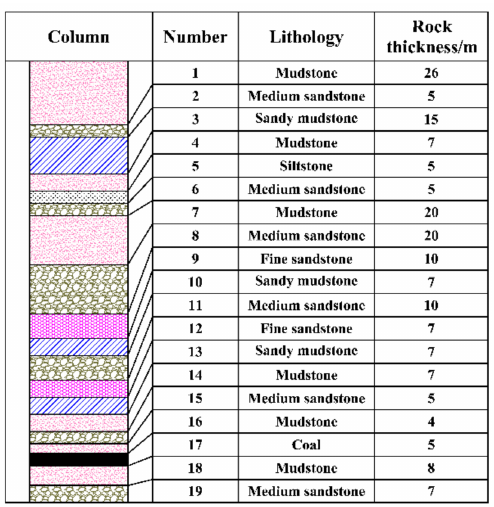
Figure 2. Histogram of certain rock strata in the Longshan Coal Mine.